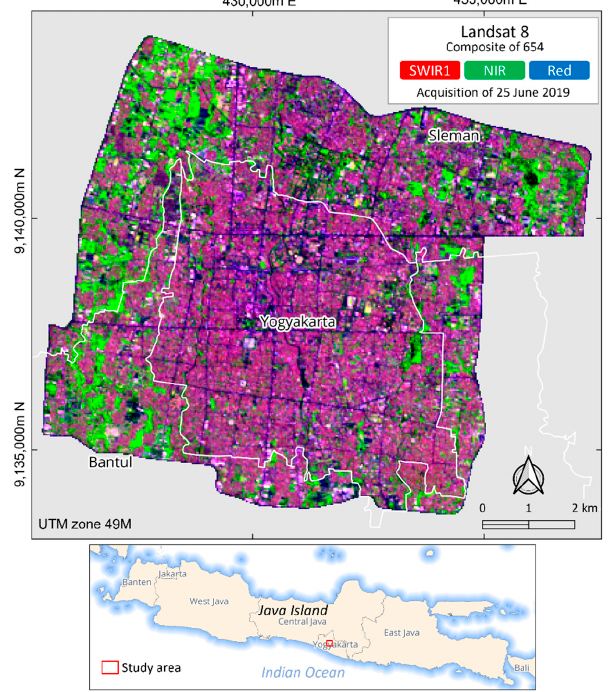
Figure 1. Study area with the background of Landsat 8 composite of 654. White lines indicate the administrative boundary at the regency level.